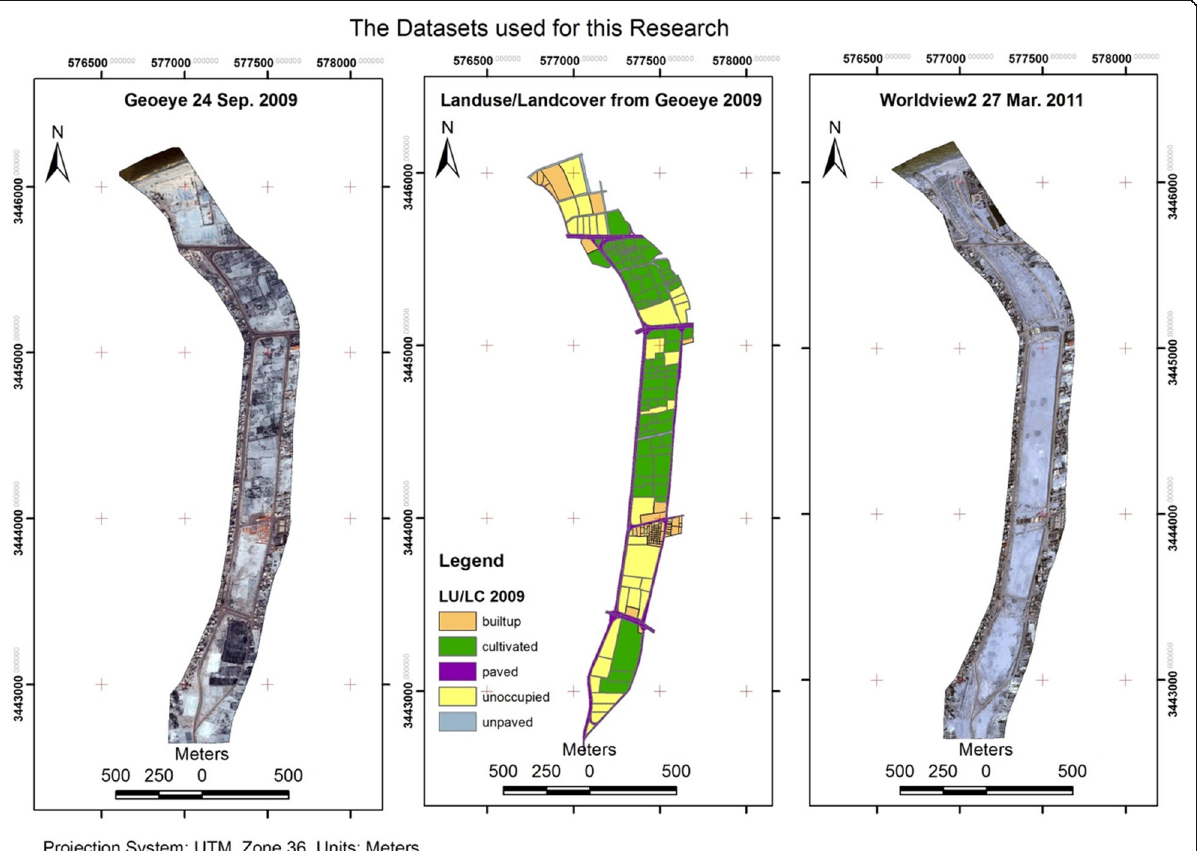
Fig. 2 The before and after satellite images and the LU/LC GIS layer used in the research